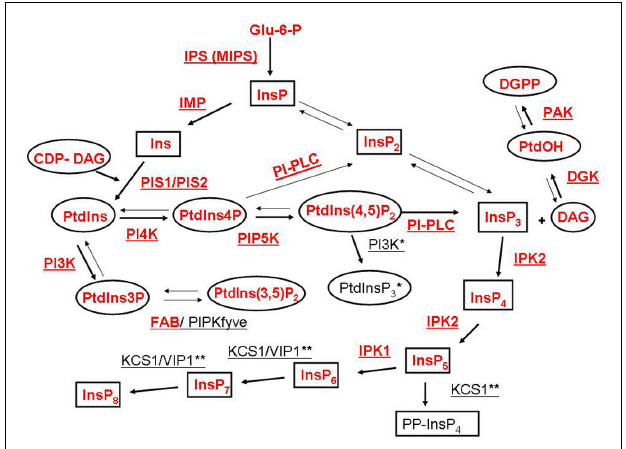
FIGURE 1 | Schematic representation of inositol phospholipids and inositol phosphate metabolism associated with the phosphoinositide (PI) pathway. A generalized PI pathway is shown. Lipid metabolites are represented by ovals, inositol and inositol phosphate derivatives are depicted by boxes and enzymes are underlined.Well characterized pathways are indicated with bold arrows. Enzymes and metabolites that have been found in plants to date are shown in red. Enzyme abbreviations are as follows: IPS, myo -inositol phosphate synthase; IMP, inositol monophosphatase; PIS, phosphatidylinositol synthase; PI3K, PtdIns 3-kinase; PI4K, PtdIns 4-kinase; PIP5K, PtdIns4P 5-kinase; FAB/PIPKfyve, PtdIns3P 5-kinase; PI-PLC, PtdIns/PtdInsP-Phospholipase C; IPK, inositol phosphate kinase; DGK, diacylglycerol kinase; PAK, PtdOH kinase; KCS1, kinase C suppressor 1 (inositol hexakisphosphate (InsP 6 ) kinase);VIP1, InsP 6 , and inositol heptakisphosphate (InsP 7 ) kinase. AnimalType I PtdIns3K enzyme activity that produces PtdIns(3,4,5)P 3 has not been identified in plants and is marked with one (*) asterisk. KCS1 andVIP1 activities have been identified in yeast and animals and are marked with two (**) asterisks.